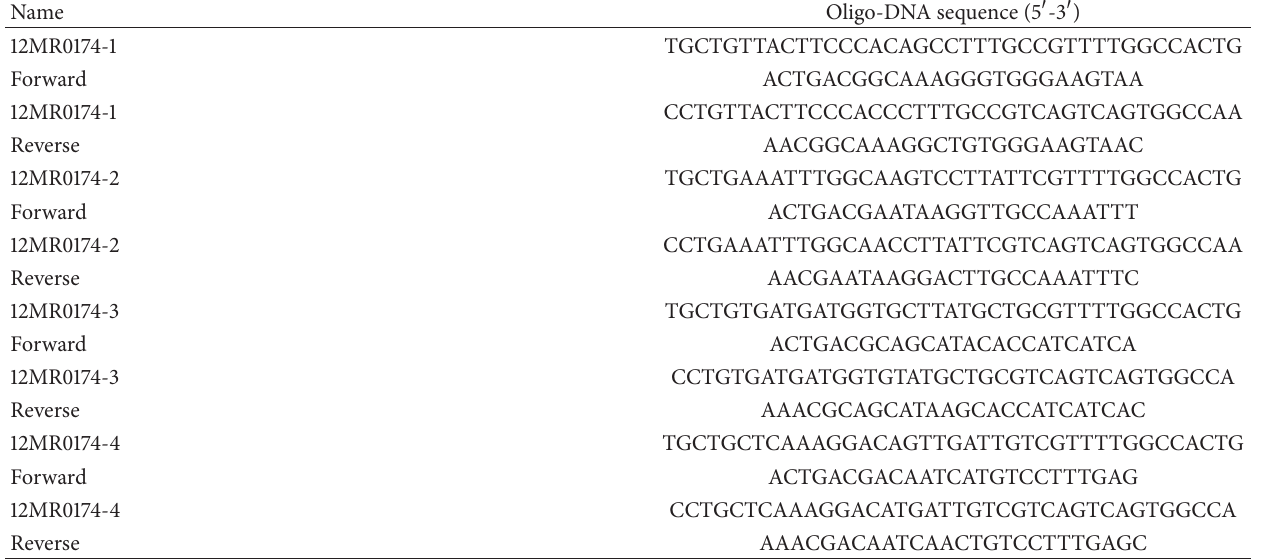
Table 1: Oligo-DNA sequences for rat